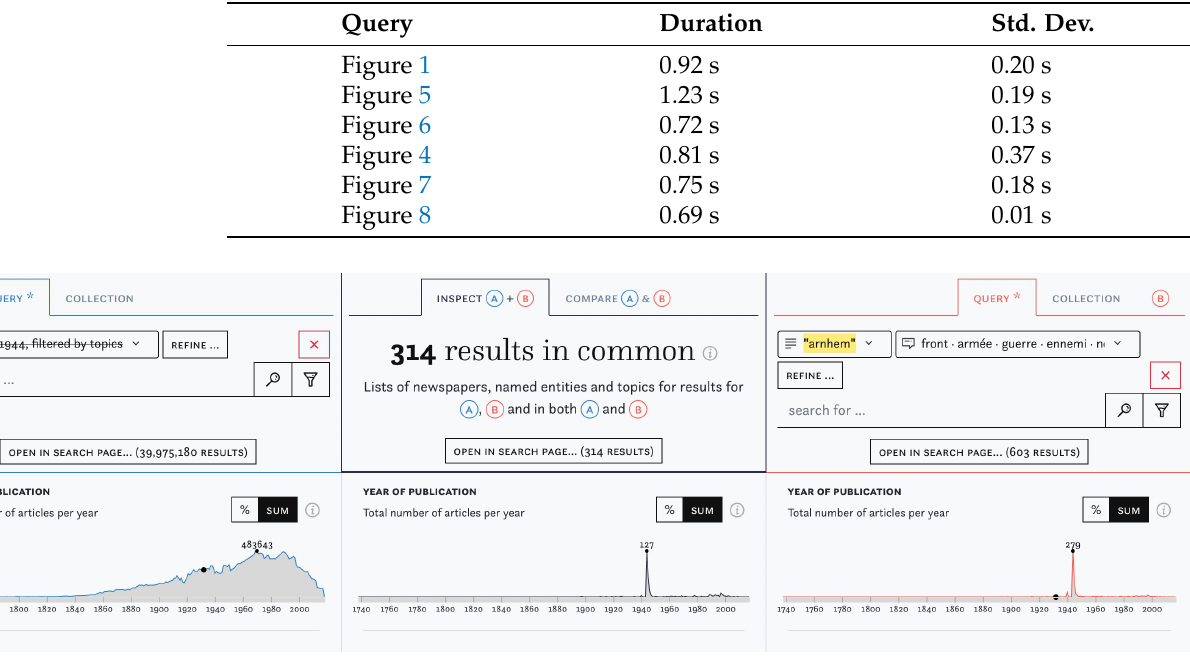
Table 2. Execution times in seconds for the queries displayed in Figures 1 and 5–8 averaged over three runs.